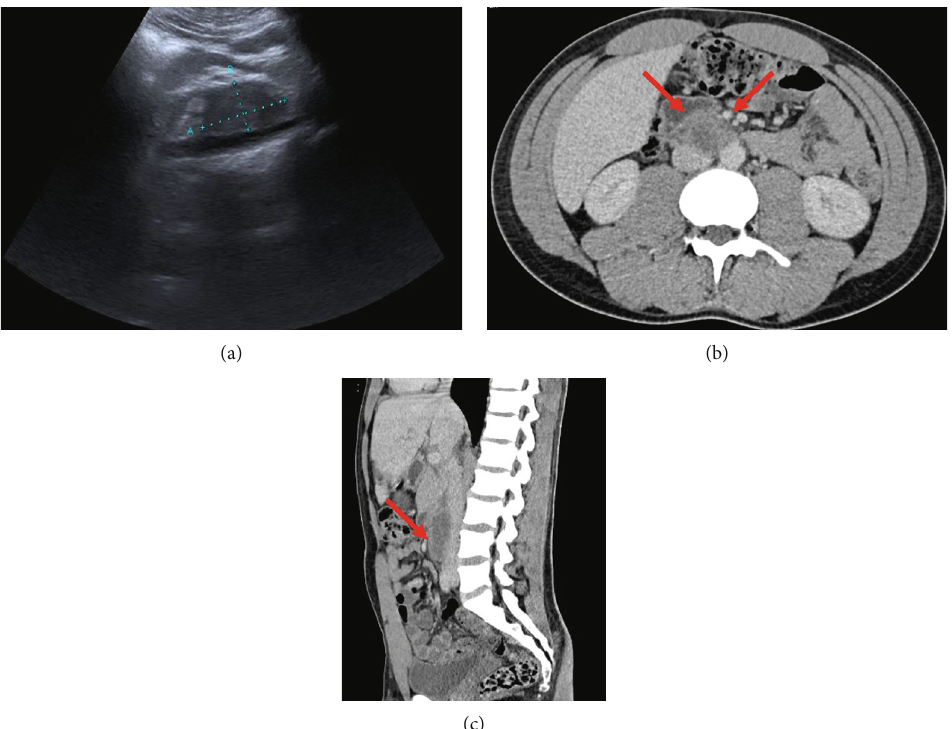
Figure 2: Ultrasound and CT. (a) Sagittal gray-scale abdominal ultrasound of the superior retroperitoneum, demonstrating a hypoechoic enlarged lymph node (between calipers). (b, c) Axial and sagittal contrast-enhanced CT abdominopelvic images showing the same enlarged lymph node (red arrows), on staging. Note the discrete fat stranding in the adjacent planes.